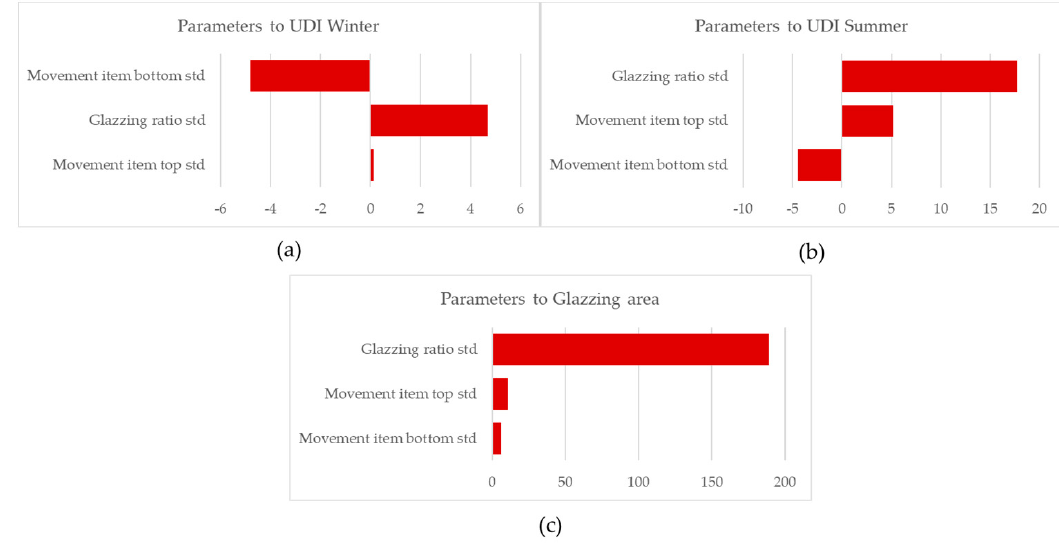
Figure 18. Sensitivity analysis showing the significant implication of each parameter toward the